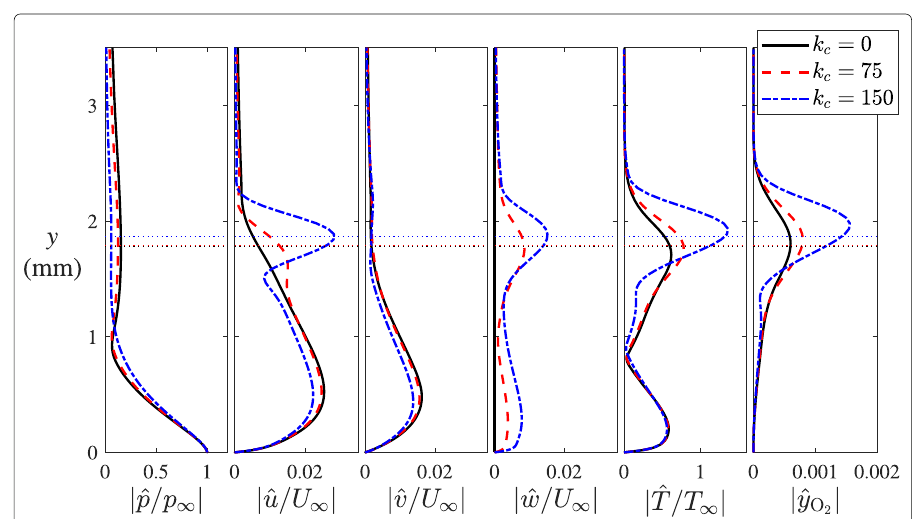
Fig. 4 Eigenvectors of the second-mode disturbance with different azimuthal wavenumbers at s of 1m . The disturbance frequency is 500kHz . The subfigures are the disturbance curves of ( a ) pressure, ( b - d ) velocities, ( e ) temperature and ( f ) mass fraction of O 2